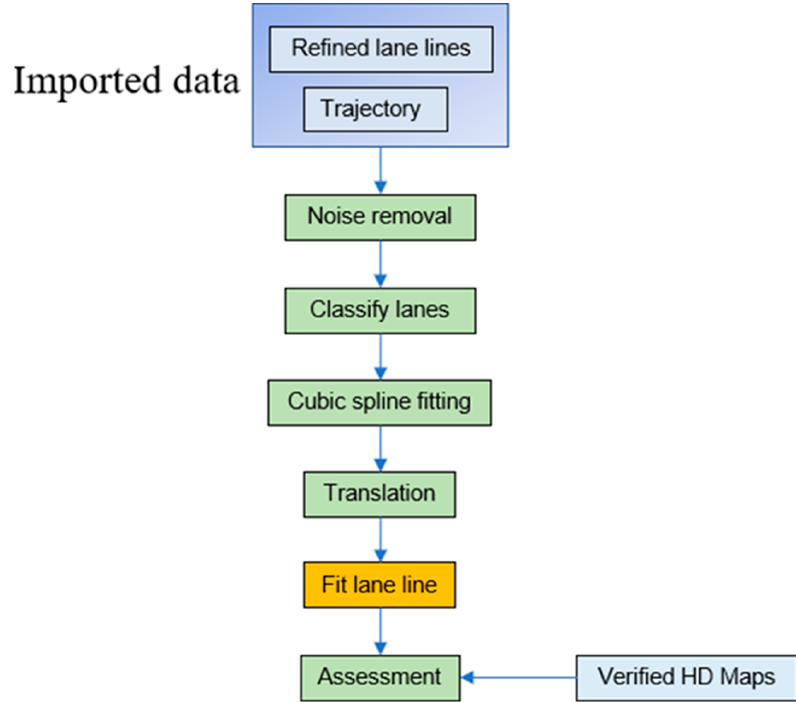
Figure 4. Flowchart of lane line modeling algorithm.